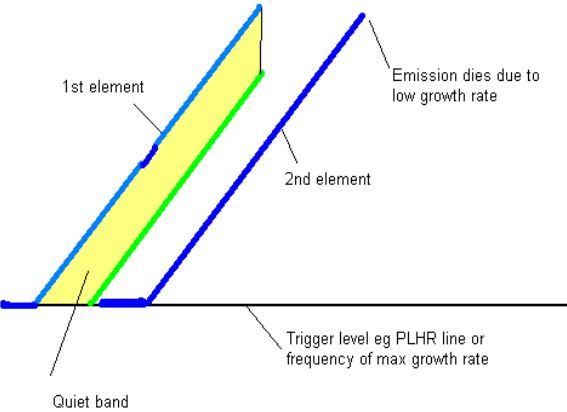
Fig. 1. Postulated mechanism for the retriggering of successive el- ements of chorus, shown in the frequency-time domain diagram- matically. Each element is developed from noise at the start fre- quency, e.g., corresponding to the frequency of maximum growth rate/instability. The element dies when the growth rate becomes too low. Spontaneous growth of the next element is delayed by the nonlinear “quiet band”